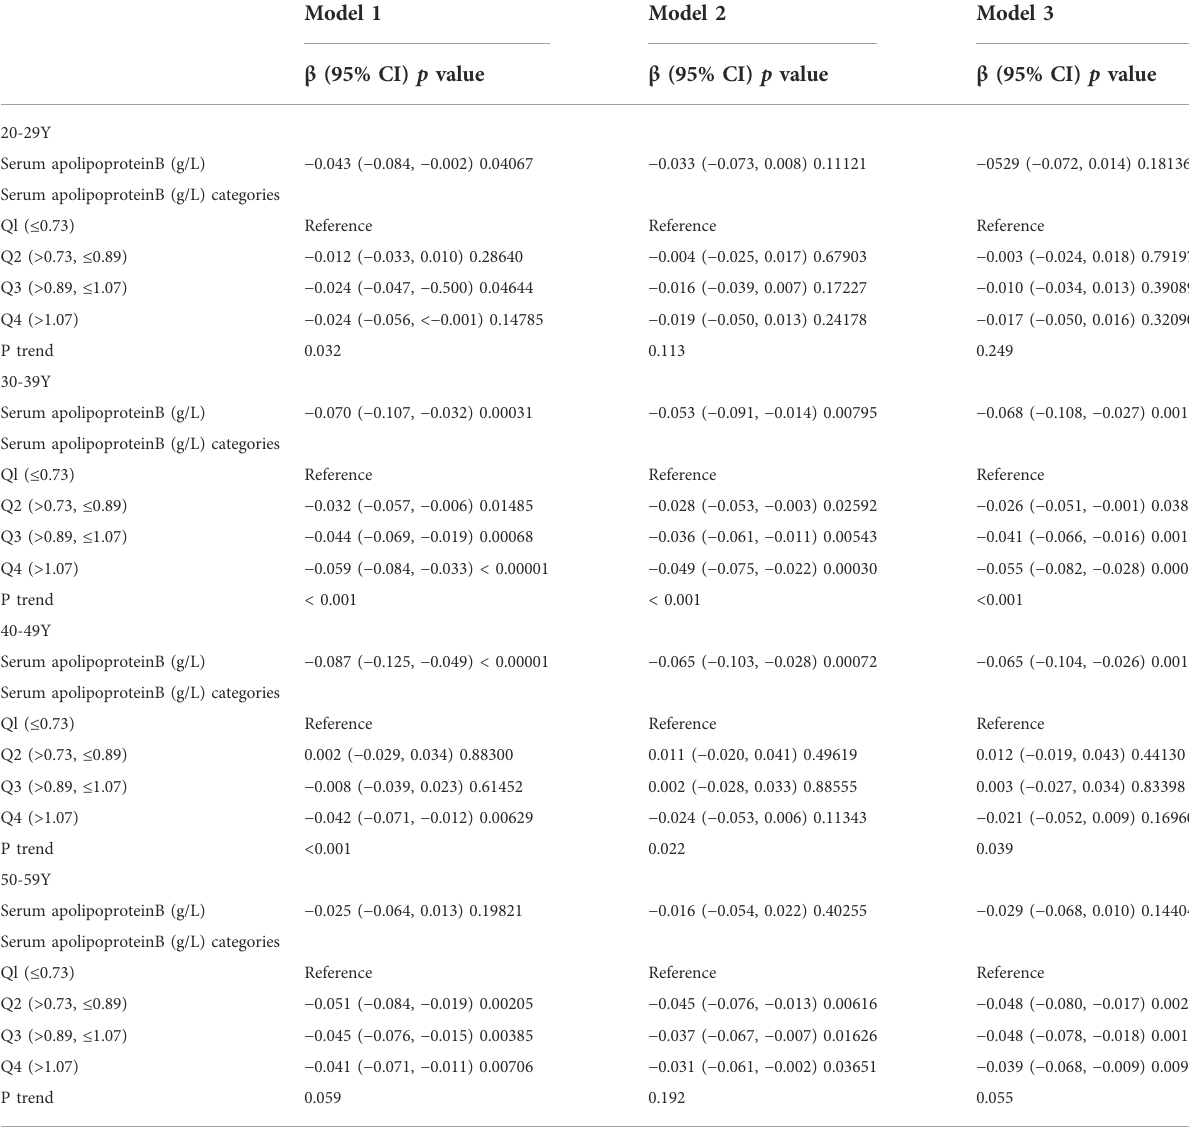
TABLE 4 Association between Serum apolipoprotein B (g/L) and lumbar bone mineral density (subgroup analysis strati fi ed by